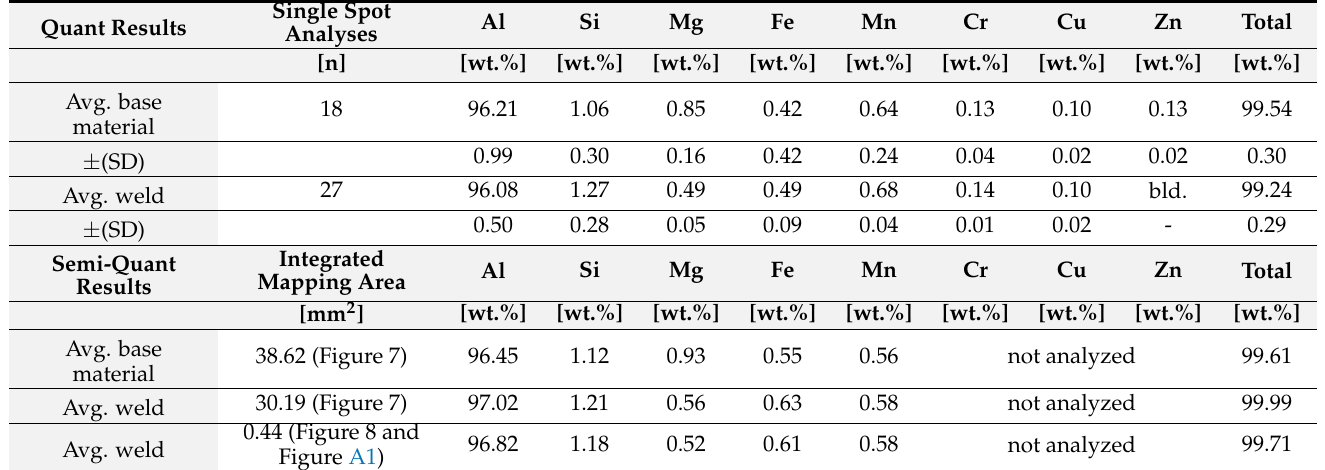
Figure 4. ( a ) example of an X-ray image of the test series D with different sized pores; ( b ) misinter- preted weld butt at the end of the weld. Table 3. EPMA results from the single spot analyses and the integrated mapping areas; SD: standard deviation; bld.: below detection